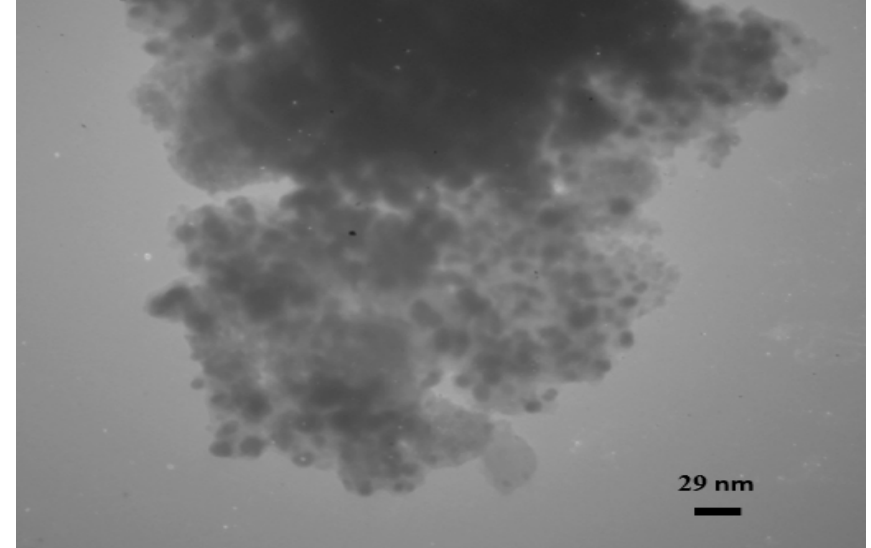
Fig. 9. TEM image of the Ag NPs/Zeolite 13X Fig.9 TEM image of the Ag NPs/Zeolite 13X nanocomposite